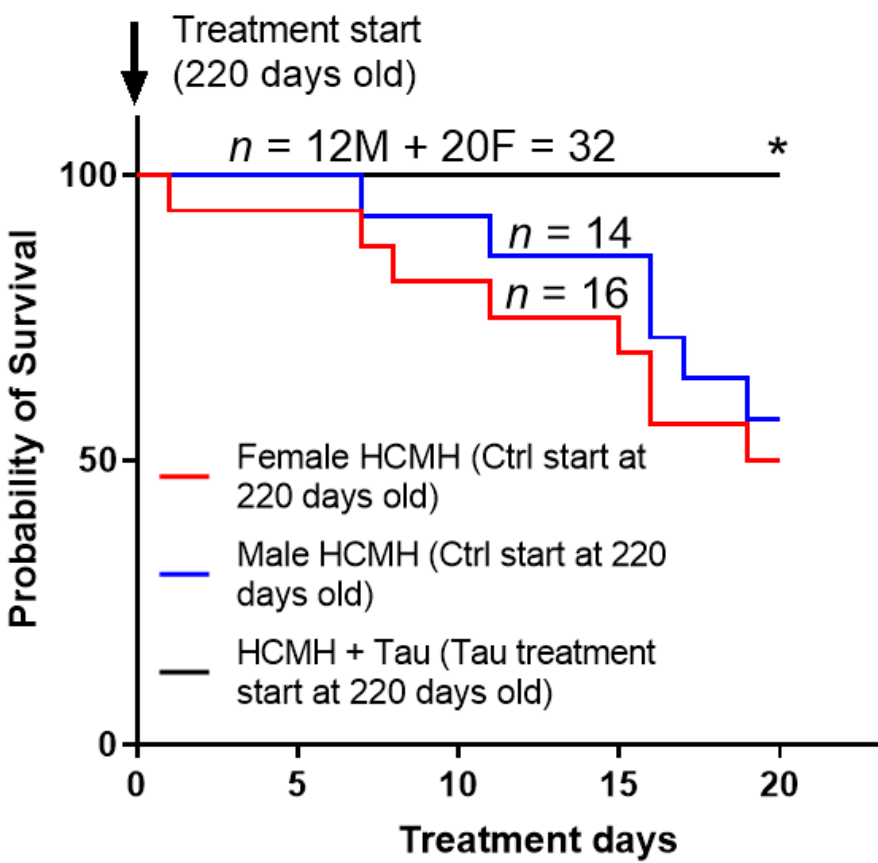
Figure 2. Curves showing the effects of preventive 20 days treatment (black plot) with taurine on the survival of male (M) and female (F) 220-day-old hereditary cardiomyopathic hamsters (HCMHs). The arrows indicate the age of HCMHs at the beginning and the end of the preventive treatment. Ctr = control non-treated animals; Tau = taurine-treated animals. Values are expressed as percent survival, and n is the number of animals. * p < 0.05.